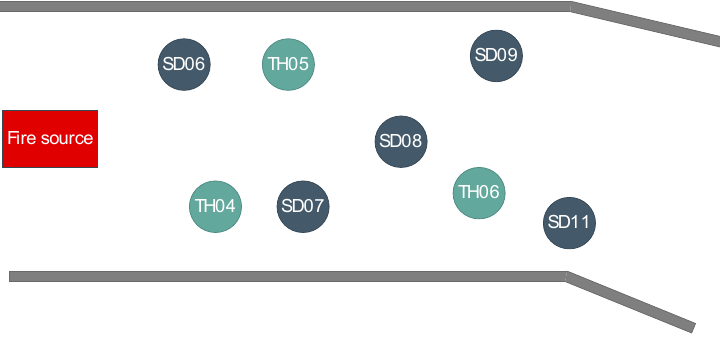
Figure 9. Top view of distribution.